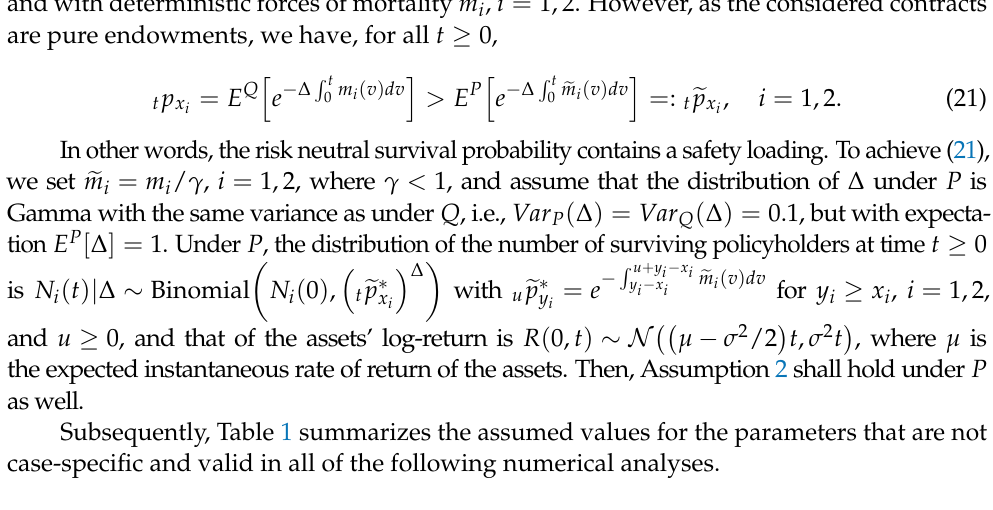
Table 1. Non case-specific parameters for numerical